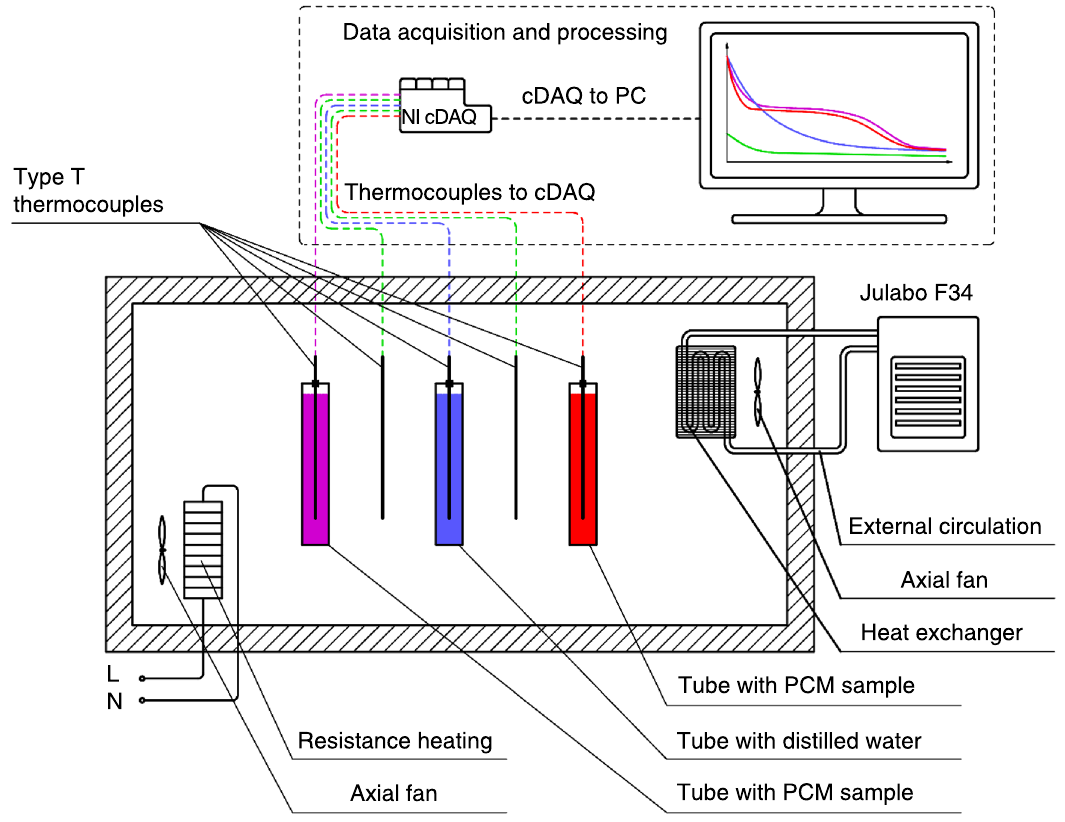
Figure 2. Schematic of the experimental apparatus for the T-history method including data acquisition and